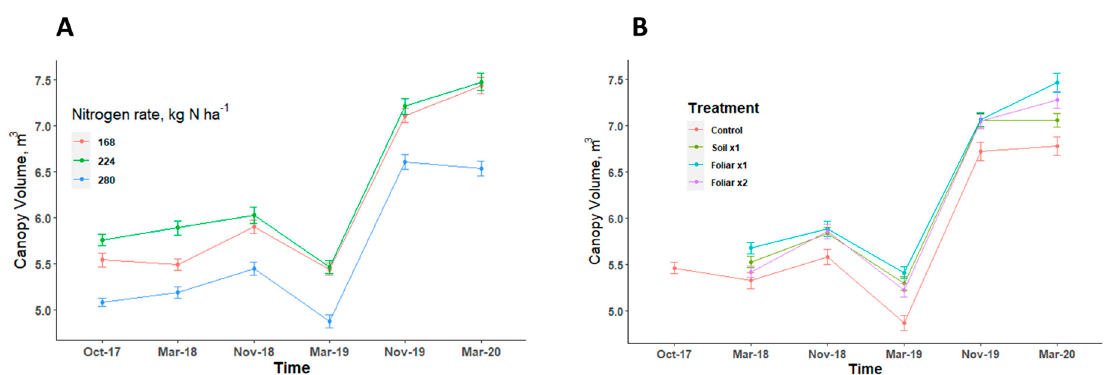
Figure 4. Canopy volume of HLB-affected trees treated with different levels of N ( A ) [n = 12] and Zn ( B ) [n = 9] with standard error bars. Treatments: control—standard soil Zn applied; foliar x1—standard soil Zn applied + foliar-applied Zn based at 1× UF/IFAS recommendations; foliar x2—2× foliar-applied Zn at UF/IFAS recommendations + standard soil Zn application; soil x1—2× soil-applied UF/IFAS recommendations (5.60 kg Zn ha − 1 ).